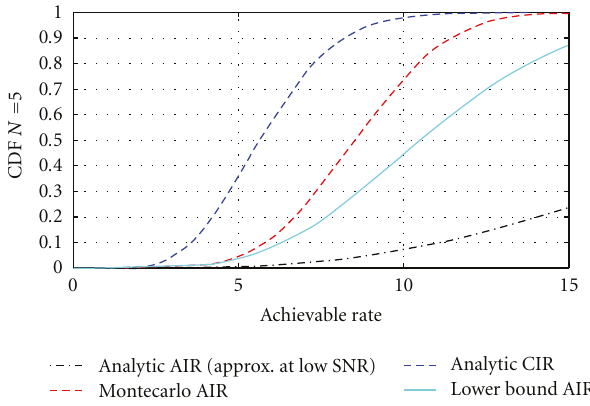
Figure 6: Comparison between cumulative density functions of the two systems with M = 5 nodes and SNR = 5 dB. We can see how for the 40% of time the rate of AIR system will be above 8bits/s/Hz while CIR system achievable rate will be above 5.2 bits/s/Hz. At high SNR the (21) is a loose upper bound for the (19). A tighter lower bound is given by 22 which is also plotted.